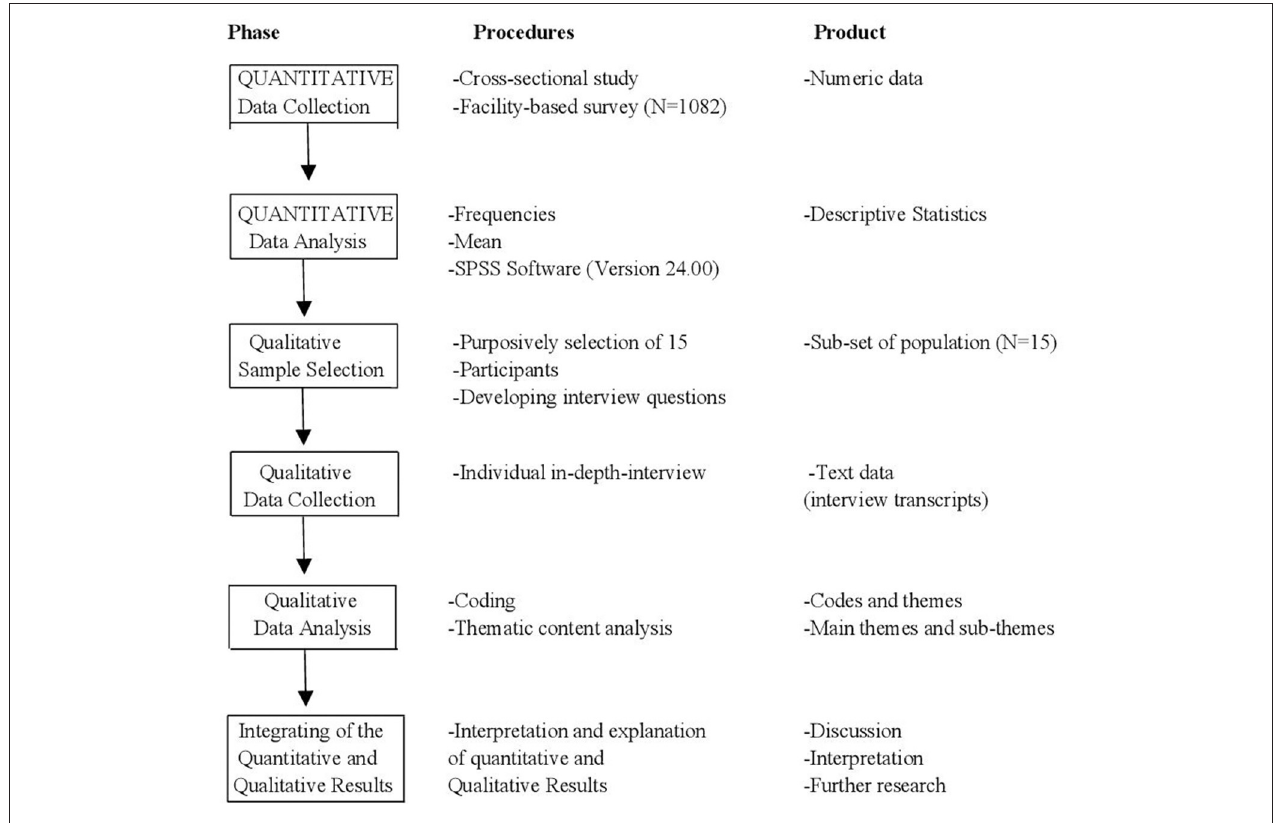
FIGURE 1 | Chart flow of the mixed methods of the